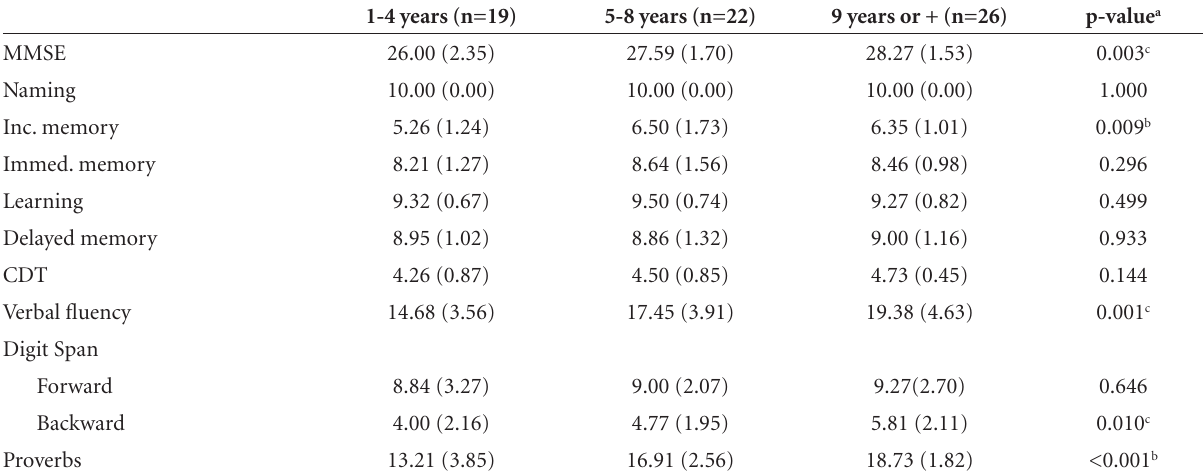
Table 2. Mean and standard deviation (in brackets) for cognitive variables of the three schooling groups.